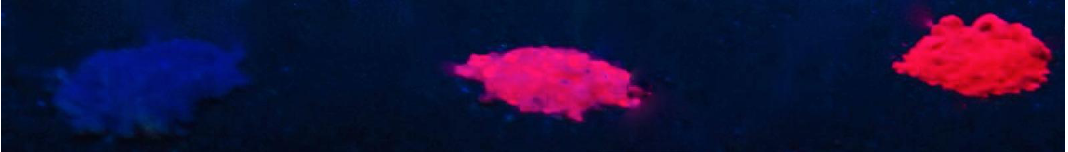
Figure 5. Digital photographs of PS-TiO 2 . From left to right: TiO 2 , P3-TiO 2 and P4-TiO 2 under UV light.